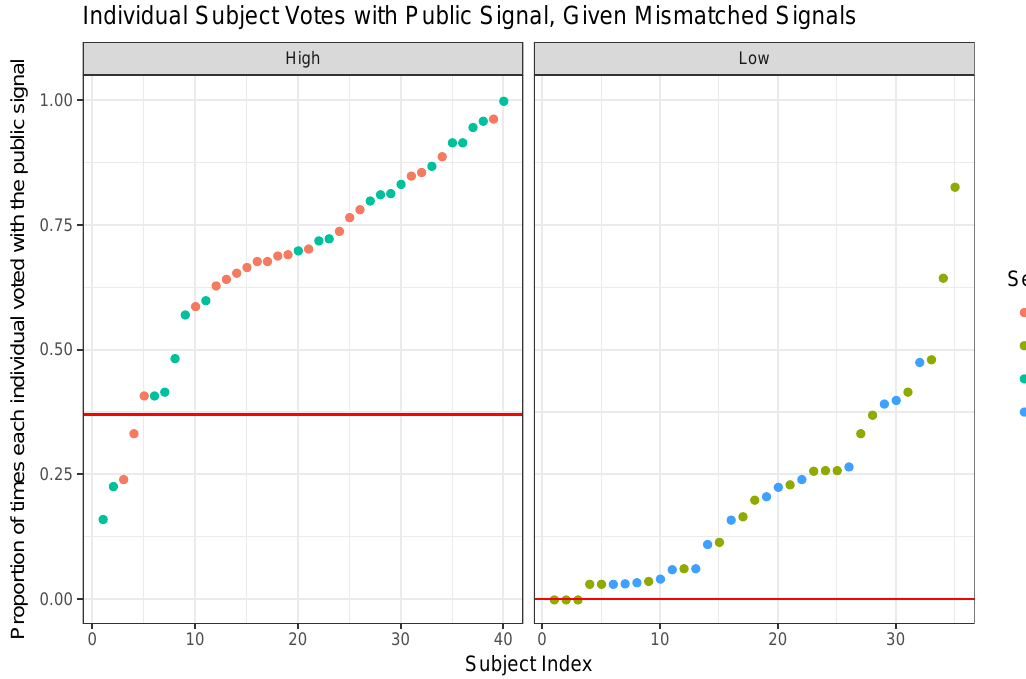
Figure A4. Proportion of times each individual voted according to the public signal in the first four sessions (with group task). The left image plots values for sessions where Q > q , the right one Q < q . Different colors correspond to different